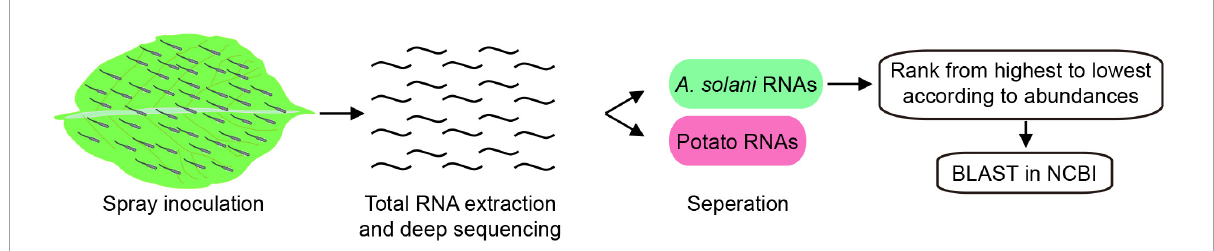
FIGURE1 Acquisition workflow of A. solani -specific candidate genes. Obtaining total RNA from spray-inoculated potato leaves by A. solani , and separating A. solani transcripts from total reads. Sorting transcripts from highest to lowest according to their abundances, and BLAST them in NCBI. Finally, verified candidate transcripts.